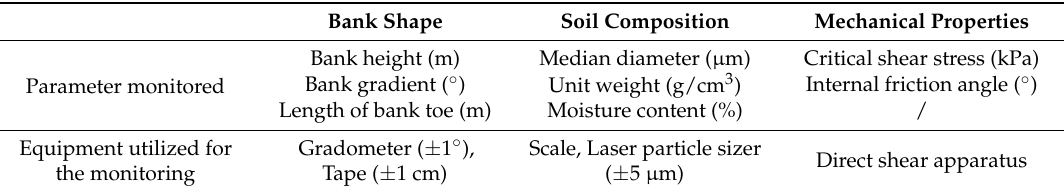
Table 1. Indexes and methods for in-site measurement.